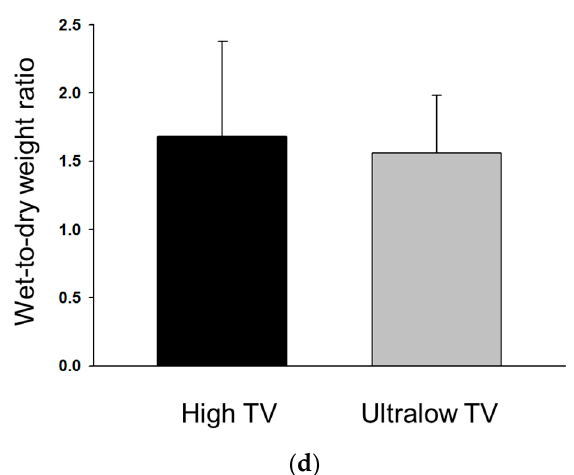
Figure 5. Representative ( a ) gross and ( b ) microscopic images of lung after 12 h of ventilator use in ultralow tidal ventilation group (left panel) and high tidal ventilation group (right panel). ( b , left panel) Mild perivascular inflammatory cell infiltration and interstitial fibrosis (H&E stain × 10; inset × 200), and ( b , right panel) more extensive infiltration of inflammatory cells (H&E stain × 40; inset × 200). Scale bars indicate 400 μ m (left panel), and 100 μ m (right panel). Comparison of ( c ) severity of lung injury assessed by the lung injury score and ( d ) lung wet-to-dry (W/D) weight ratio; * high-tidal-volume ventilation versus ultralow tidal ventilation under ECMO support, p < 0.05.